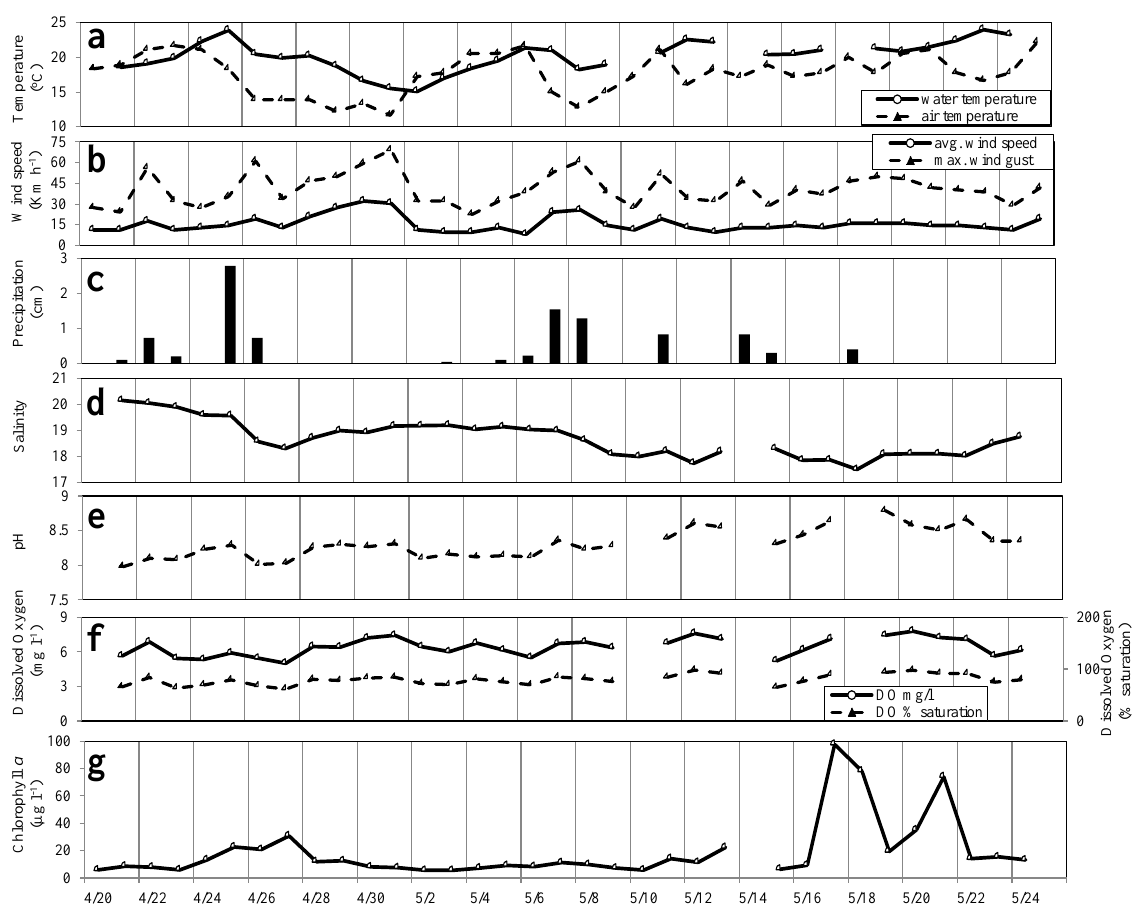
Figure 1. Daily measurements of physical and chemical parameters in the Lafayette River from 20 April to 25 May 2006. Water temperature (°C) was measured at the sampling site using the Hydrolab and mean daily air temperatures were measured at Norfolk International Airport (ORF) ( a ). Mean daily wind speed and maximum daily speed of wind gusts (miles h −1 ) were measured at Norfolk International Airport (ORF) ( b ). Daily cumulative precipitation (cm) was also measured at ORF ( c ). Salinity ( d ), pH ( e ), dissolved oxygen (mg L −1 ), and percent saturation ( f ) were measured using the Hydrolab